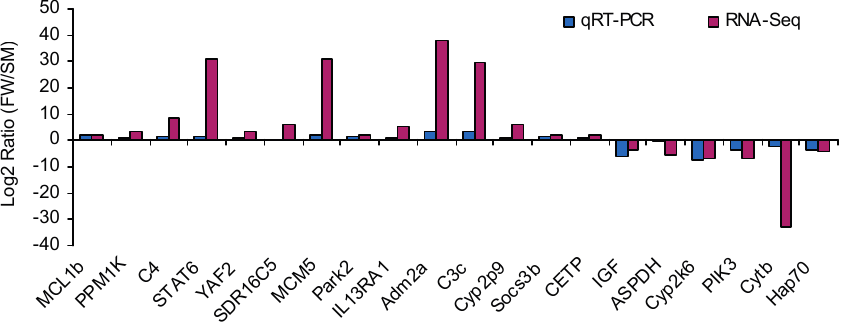
Figure 4. DEGs validated by qRT-PCR. Comparison of RNA-Seq and qRT-PCR validation results. x -axis shows genes in three tissues validated in this study; y -axis shows the log 2 ratio of expression in FW (freshwater) versus SM (spawning migration) Amur ide. MCL1b, myeloid cell leukemia sequence 1b; PPM1K, protein phosphatase 1K; C4, complement component 4; STAT6, signal transducer and activator of transcription 6, interleukin-4 induced; YAF2,YY1 associated factor 2; SDR16C5, short chain dehydrogenase/reductase family 16C, member 5b; MCM5, minichromosome maintenance deficient 5; Park2, Parkin 2; IL13RA1, interleukin 13 receptor, α 1; Adm2a, adrenomedullin 2a; C3c, complement component c3c; cytokine signaling 3b; CETP, cholesteryl ester transfer protein, plasma; IGF, Insulin-like P450, family 2, subfamily K, polypeptide 6; PIK3, phosphoinositide-3-kinase, regulatory subunit 1 (p85 α ); Cytb, cytochrome b, mitochondrial; Hap70, heat shock cognate 70 kD protein, tandem duplicate